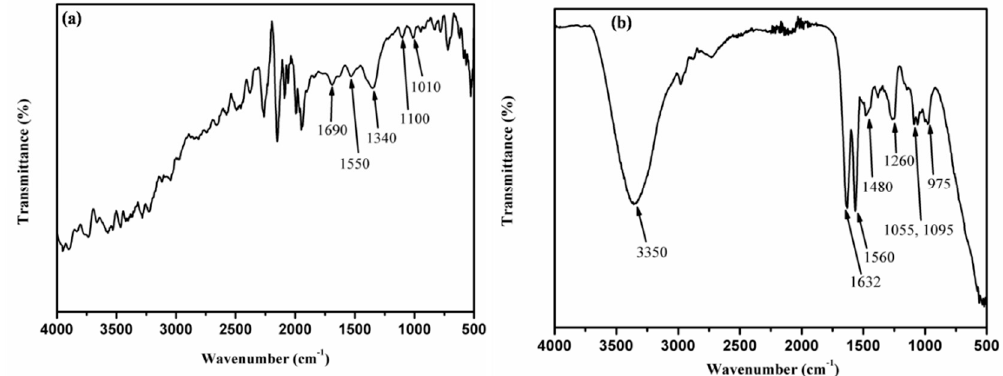
Figure 3. FTIR data of ( a ) APTES / nY 2 O 3 / ITO and ( b ) anti-CYFRA-21-1 / APTES / nY 2 O 3 / ITO electrode.